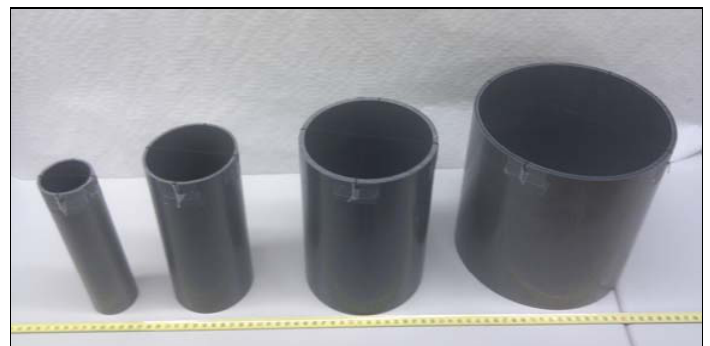
Figure 5. Set of PVC cylinders used as